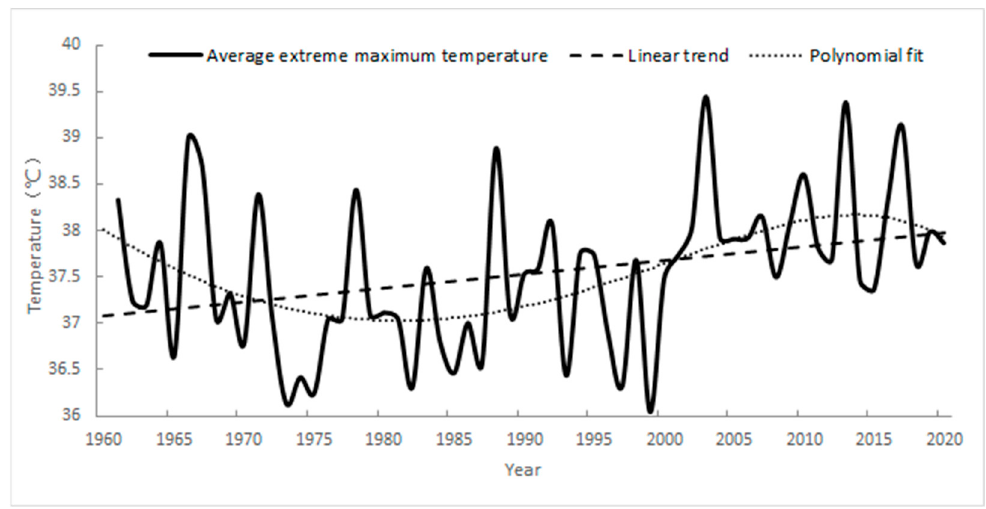
Figure 5. Interannual variation in mean extreme maximum temperature in East China during the period 1961–2020.